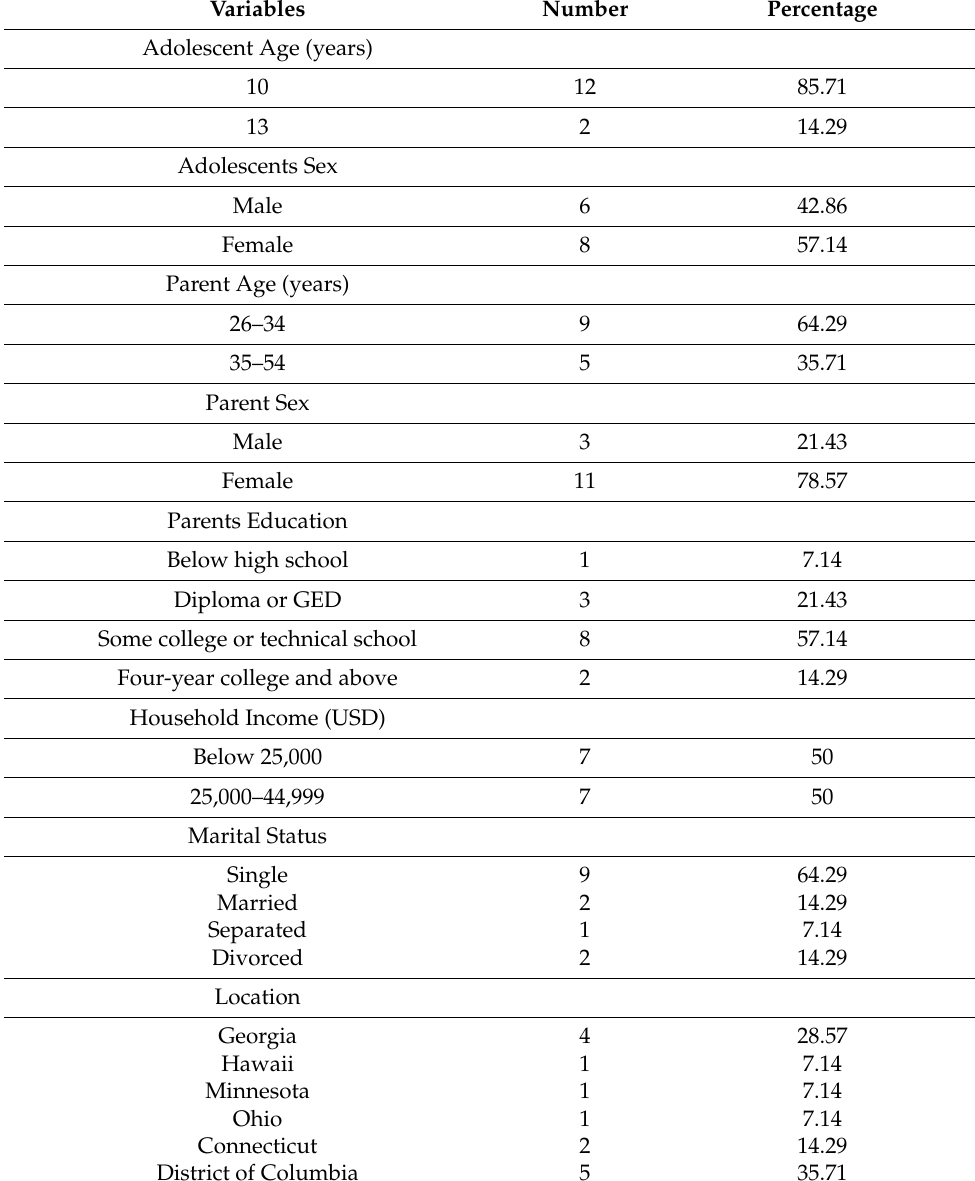
Table 4. Demographic data of the